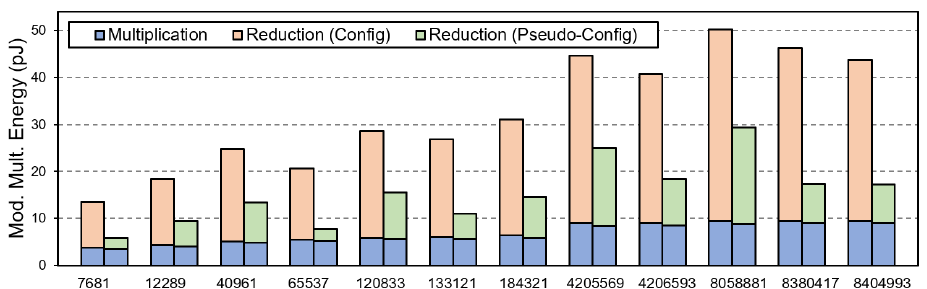
Figure 3: Comparison of modular multiplication energy for the two reduction architectures.